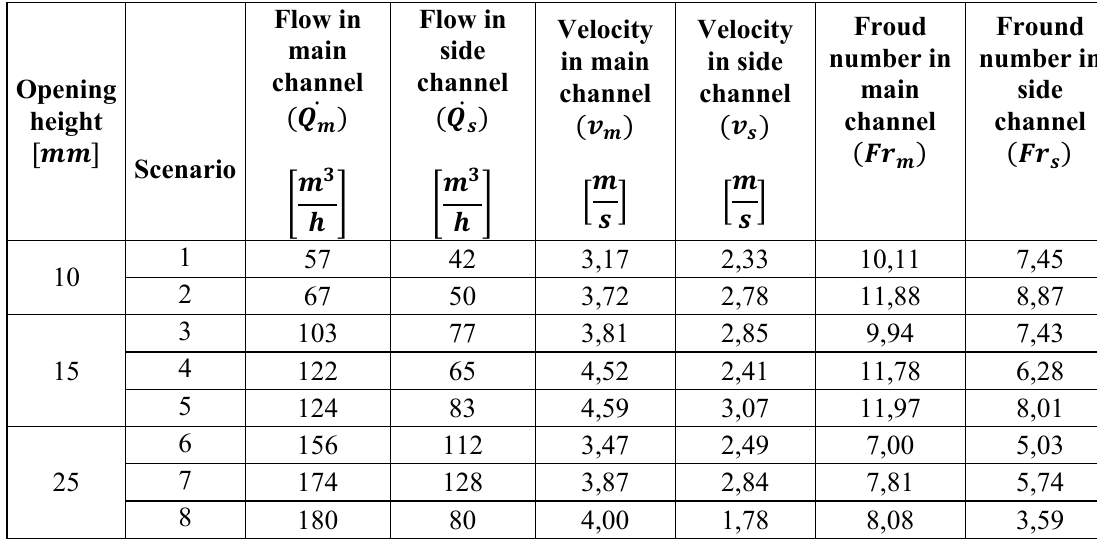
Table 1: Scenarios for